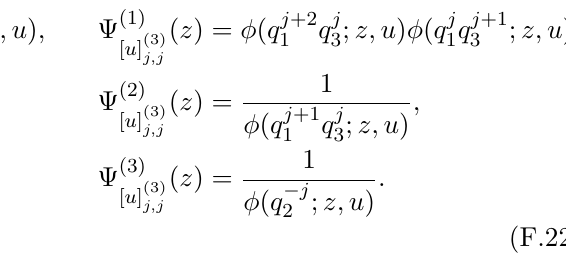
The charge functions